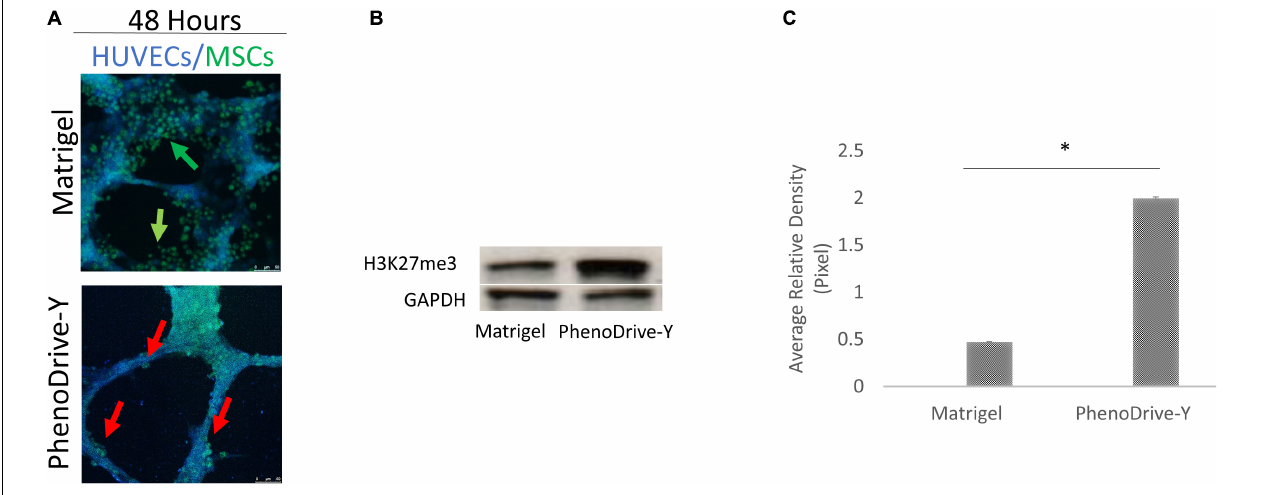
FIGURE 2 | Mesenchymal stromal cell (MSC) organization on both substrates during co-culture conditions after 48 h incubation. (A) MSCs were stained with CD90 ( green ). Scale bar , 50 µ m. (B) Western blot analysis of the levels of H3K27me3 compared to the GAPDH loading control. Green arrows , HUVEC tubules, red arrows , individual, and clusters of MSCs. (C) Quantification of H3K27me3 expression by image analysis; * p <